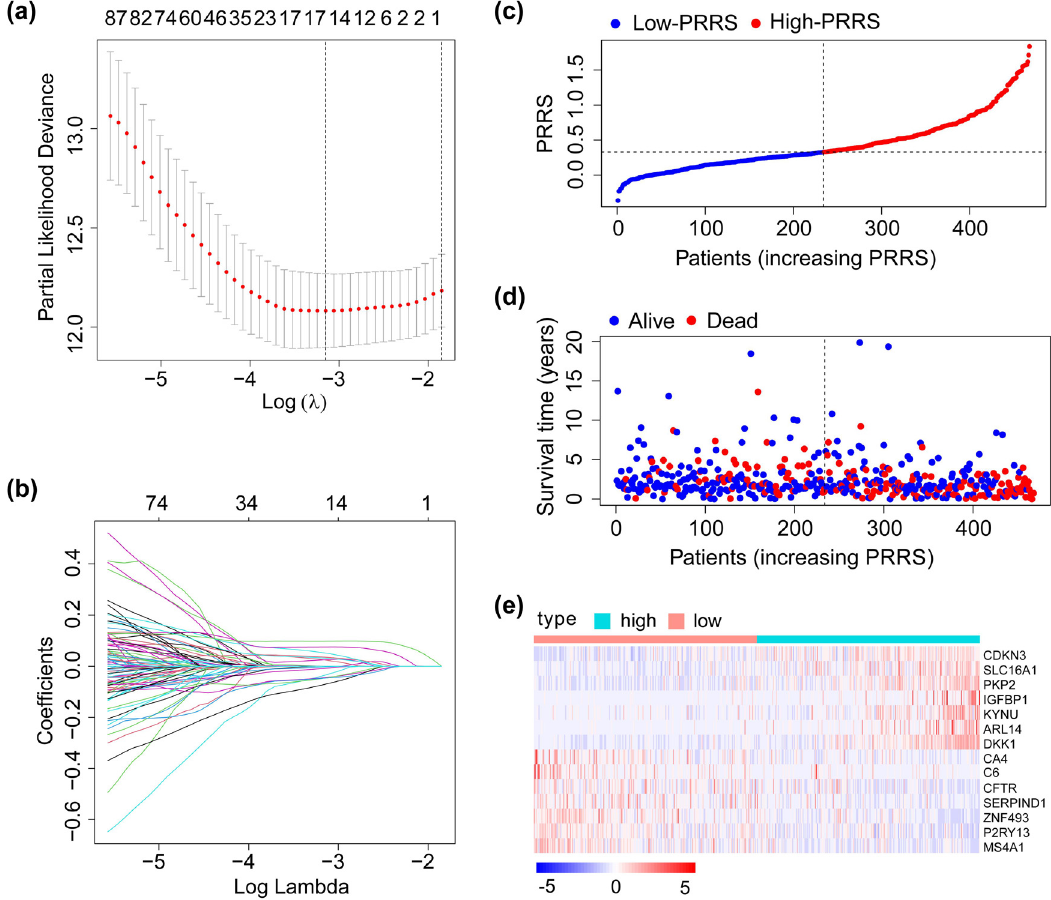
Figure 2: Construction of PRRS using TCGA_LUAD dataset. ( a and b ) LASSO Cox regression model was constructed from 125 prognosis - related genes. The 14 crucial genes were generated by the best - fi t pro fi le. ( c ) Distribution and cuto ff value of the PRRS. ( d ) OS and survival status of patients in H - PRRS and L - PRRS groups. ( e ) Expression heatmap of the 14 crucial genes in the TCGA_LUAD